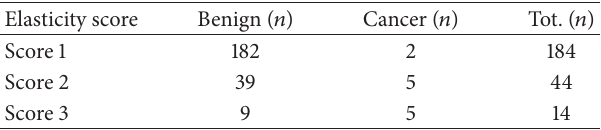
Table 2: Elasticity score of the 242 nodules submitted to cytology that resulted in benign nodules or